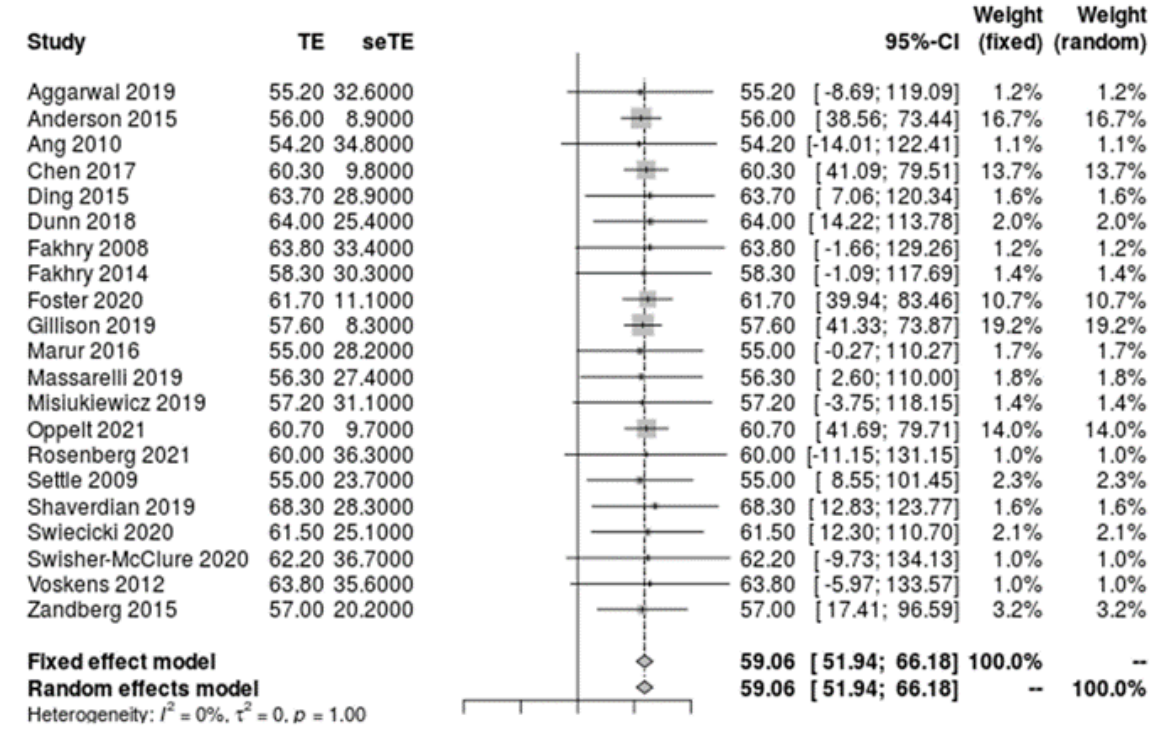
306 NR = Not reported. * All trials were classified as Level 1 according to the OCEBM LOE. Of the 2995 included patients, 2918 patients were reported by sex, 2457 were reported by age, 1993 were reported by race, 2668 were reported by tobacco and alcohol history, and 2162 were reported by primary tumor site. The mean patient age was 59.1 [51.9, 66.2] years (Figure 2) and the mean pack years for smoking history was 4.2 [ −2 .6, 11.1] years (Figure 3). Overall, patients were found to be significantly predominately white and male, with no history of smoking tobacco, a current drinking status, and tumors originating from the tonsil. A funnel plot with Egger’s test ( −0 .11, 95% CI −1 .10 to 0.88, p = 0.82) demon- strated all studies were within the funnel, suggesting little publication bias (Figure 4). Ta-